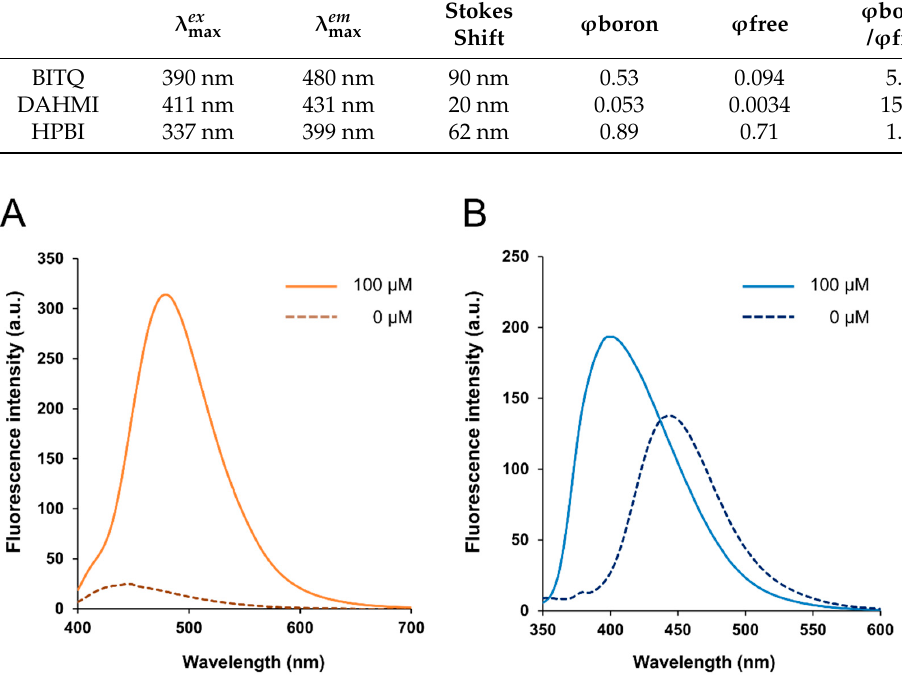
Figure 2. Fluorescence spectra of ( A ) BITQ (1.0 µM) and ( B ) HPBI (1.0 µM) 15 min after the addition of BPA (0 or 100 µM) in 0.5% DMSO/H 2 O. ( λ ex: HPBI; 337 nm, BITQ; 390 nm).